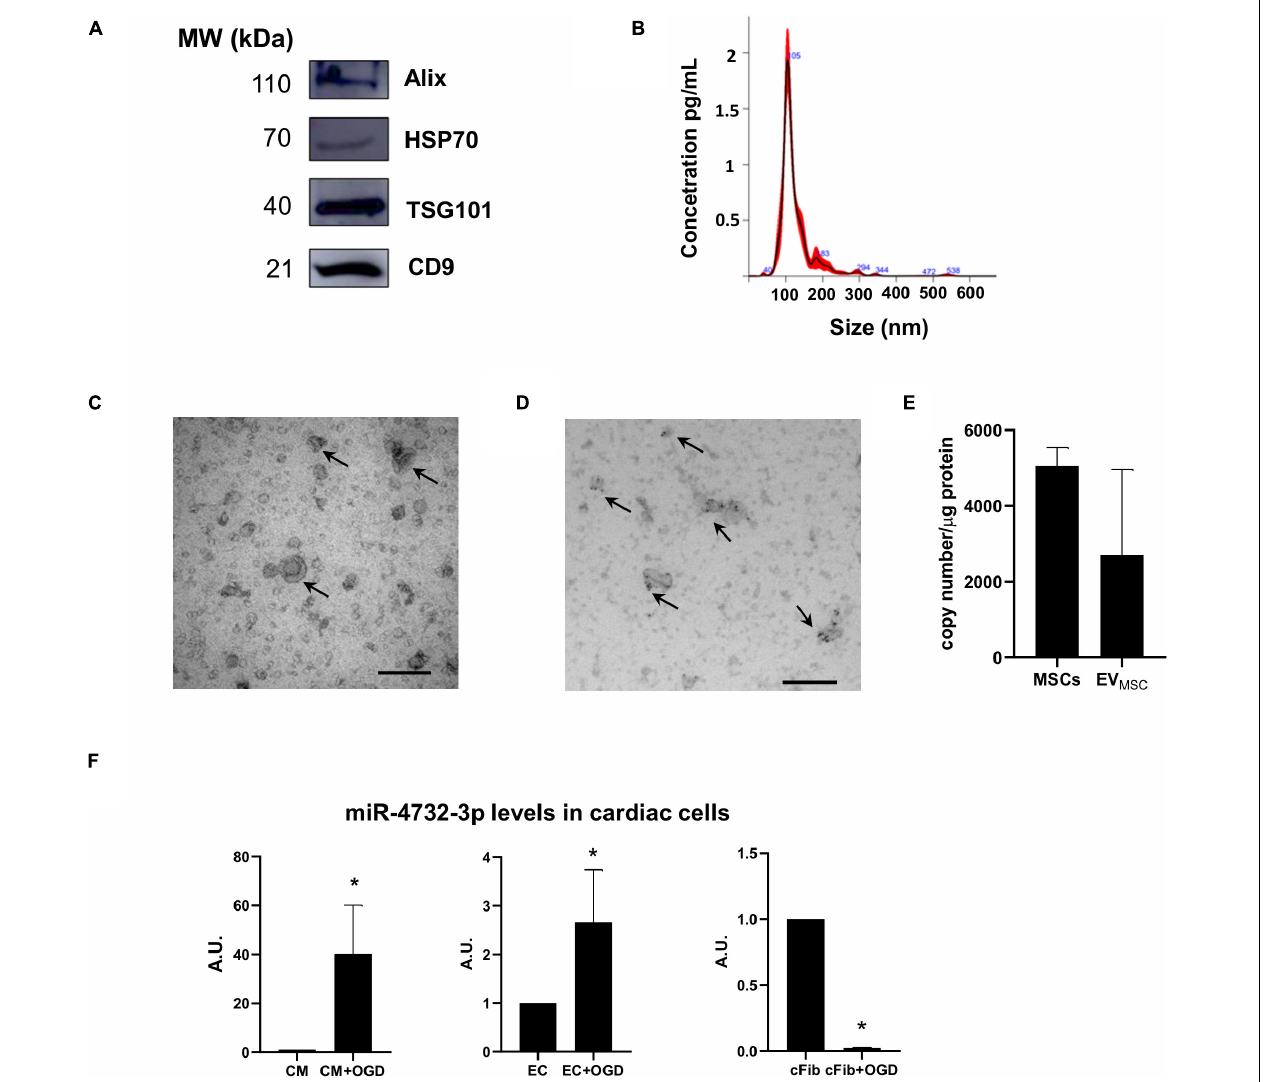
FIGURE 1 | Characterization of EVs from immortalized dental pulp-derived MSC. (A) Representative western blot analysis of extracellular vesicle markers. (B) Representative histogram of EV size analyzed with the NanoSight NS300 instrument ( n = 3). (C) Representatives image of isolated EVs analyzed by electron microscopy. (D) Representative image of EVs stained with immunogold anti-CD63 antibody and analyzed by electron microscopy. (E) Levels of miR-4732-3p in MSCs and in EVs released from these cells ( n = 3). (F) Levels of miR-4732-3p in neonatal rat cardiomyocytes (NRCM) ( n = 3), human umbilical cord blood vein cells (EC) ( n = 4) and cardiac fibroblasts (cFib) ( n = 4) in the presence or absence of oxygen glucose deprivation (OGD) (* p < 0.05). Scale bar = 200